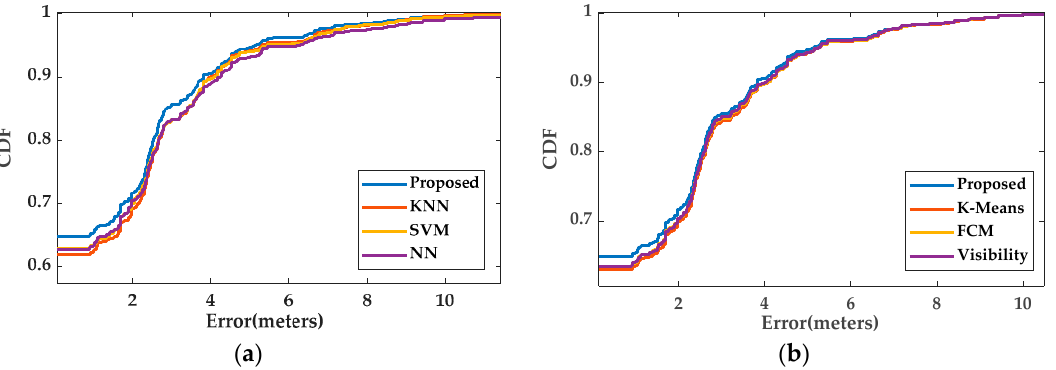
Figure 9. CDFs of the positioning errors from the benchmark and proposed localization techniques in consideration: ( a ) comparison with the flat classification methods; ( b ) comparison with the hierarchical classification methods.